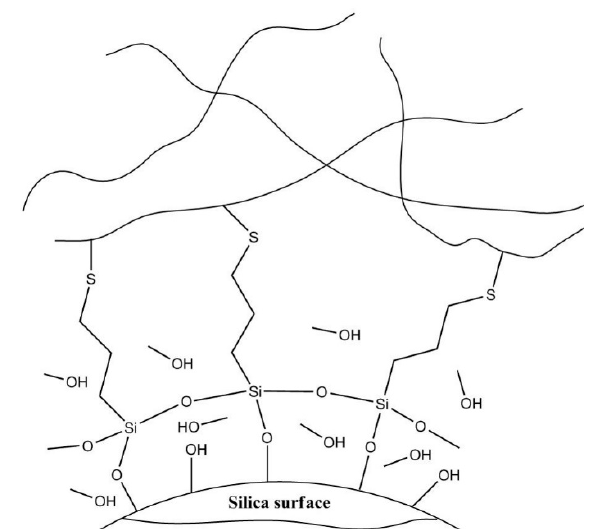
Figure 9. Schematic of the bonding of SCAs to a silica surface and the side reaction of the modified silica.